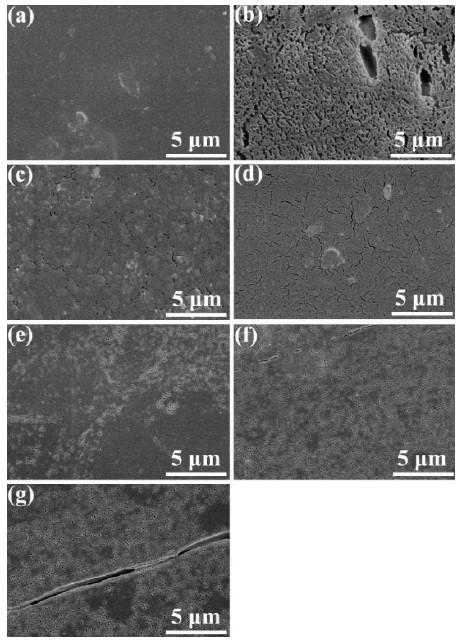
Figure 15. ( a ) Plots of mass loss as a function of degradation time and ( b ) plots of mass loss as a function of PLA content for POM/PLA blends.